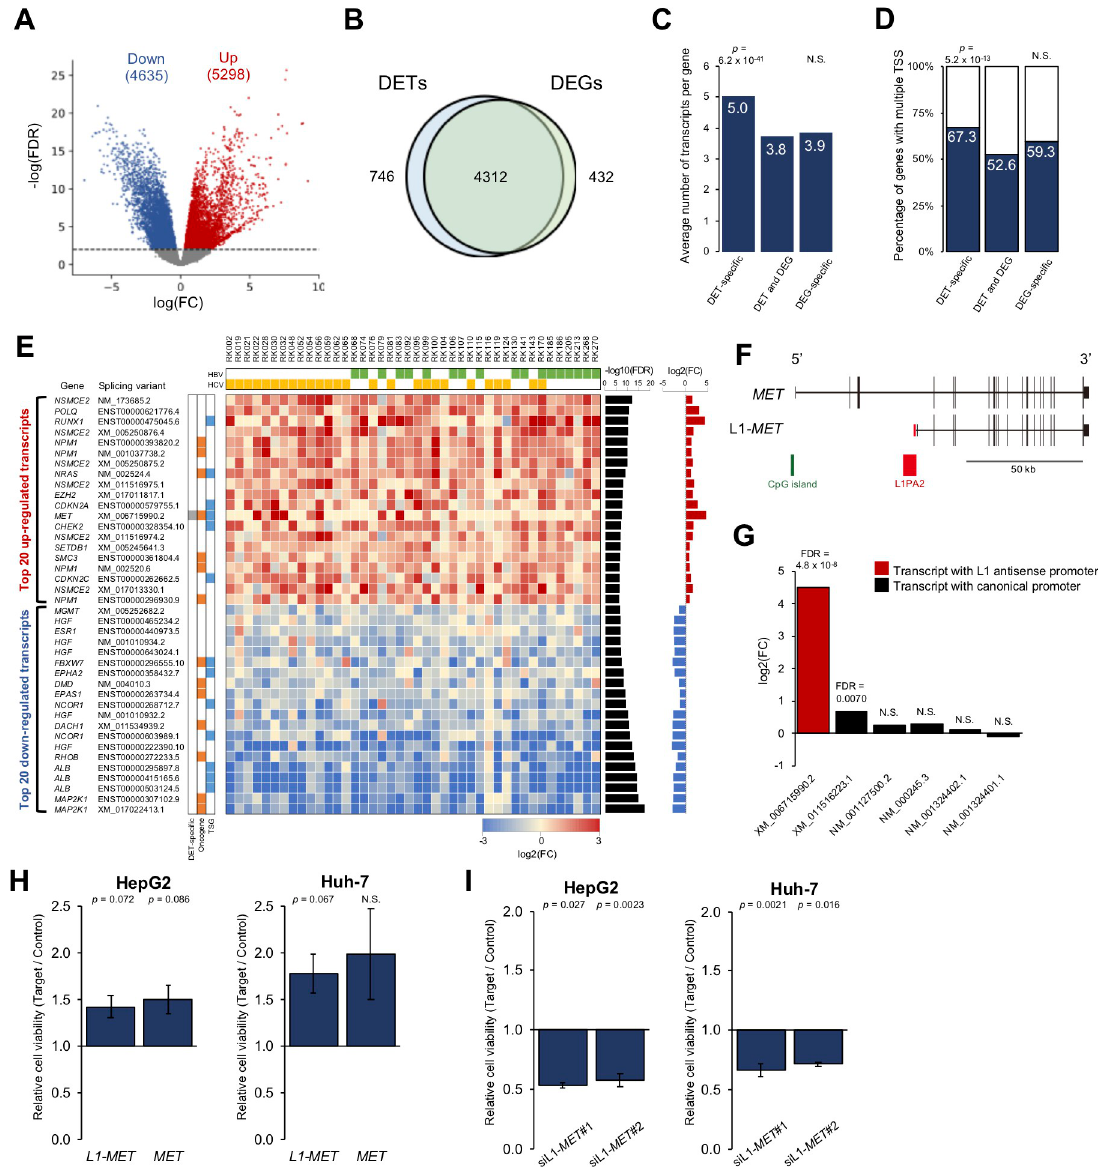
Fig 3. Landscape of significantly differentiated transcripts between HCCs and matched non-cancerous livers. ( A ) Volcano plot of DETs in cancers and non-cancerous livers. Red and blue dots represent transcripts that were significantly up- and down-regulated (FDR < 0.01), respectively. ( B ) Venn diagram of the number of genes with DETs and DEGs. ( C ) Comparison of the average number of transcripts per gene for each item in the Venn diagram in B . P -values for the abundance of transcripts per gene in DET-specific and DEG-specific genes were calculated by the Wilcoxon rank-sum test. The numbers of transcripts in each gene were compared for DET- specific genes and other genes and for DEG-specific genes and other genes. ( D ) Percentage of genes with multiple TSS for each item in the Venn diagram in B . P -values for the enrichment of genes with multiple TSS in DET-specific and DEG-specific genes were calculated by Fisher’s exact test. The numbers of TSS in each gene were compared for DET-specific genes and other genes and for DEG-specific genes and other genes. ( E ) The landscape of DETs in driver genes. Twenty up-regulated and down-regulated DETs are shown in order of lower FDR. Heatmap showing the expression differences (log2(fold change)) in cancer and matched non-cancerous livers. ( F ) Schematics diagram of the structural differences in L1- MET (XM_006715990.2) and other MET transcripts. L1- MET has the L1-derived first exon shown in red. ( G ) Bar chart showing expression differences between cancers and matched livers in MET transcripts. The red bar represents the MET transcript with the L1 antisense promoter, and black bars represent MET transcripts with the canonical promoter. P - values were obtained using quasi-likelihood methods in EdgeR software [40]. The Benjamini-Hochberg method was used for multiple testing correction (FDR). ( H ) Effect of L1- MET overexpression on the proliferation of HepG2 and Huh-7 cell lines assessed by CCK-8. P - values were calculated by the one-sample t-test (n = 3). ( I ) Effect of L1- MET knockdown on the proliferation of HepG2 and Huh-7 cell lines assessed by CCK-8. P -values were calculated by the one-sample t-test (n = 3). Error bars represent the standard error of the mean. N. S.: Not significant.